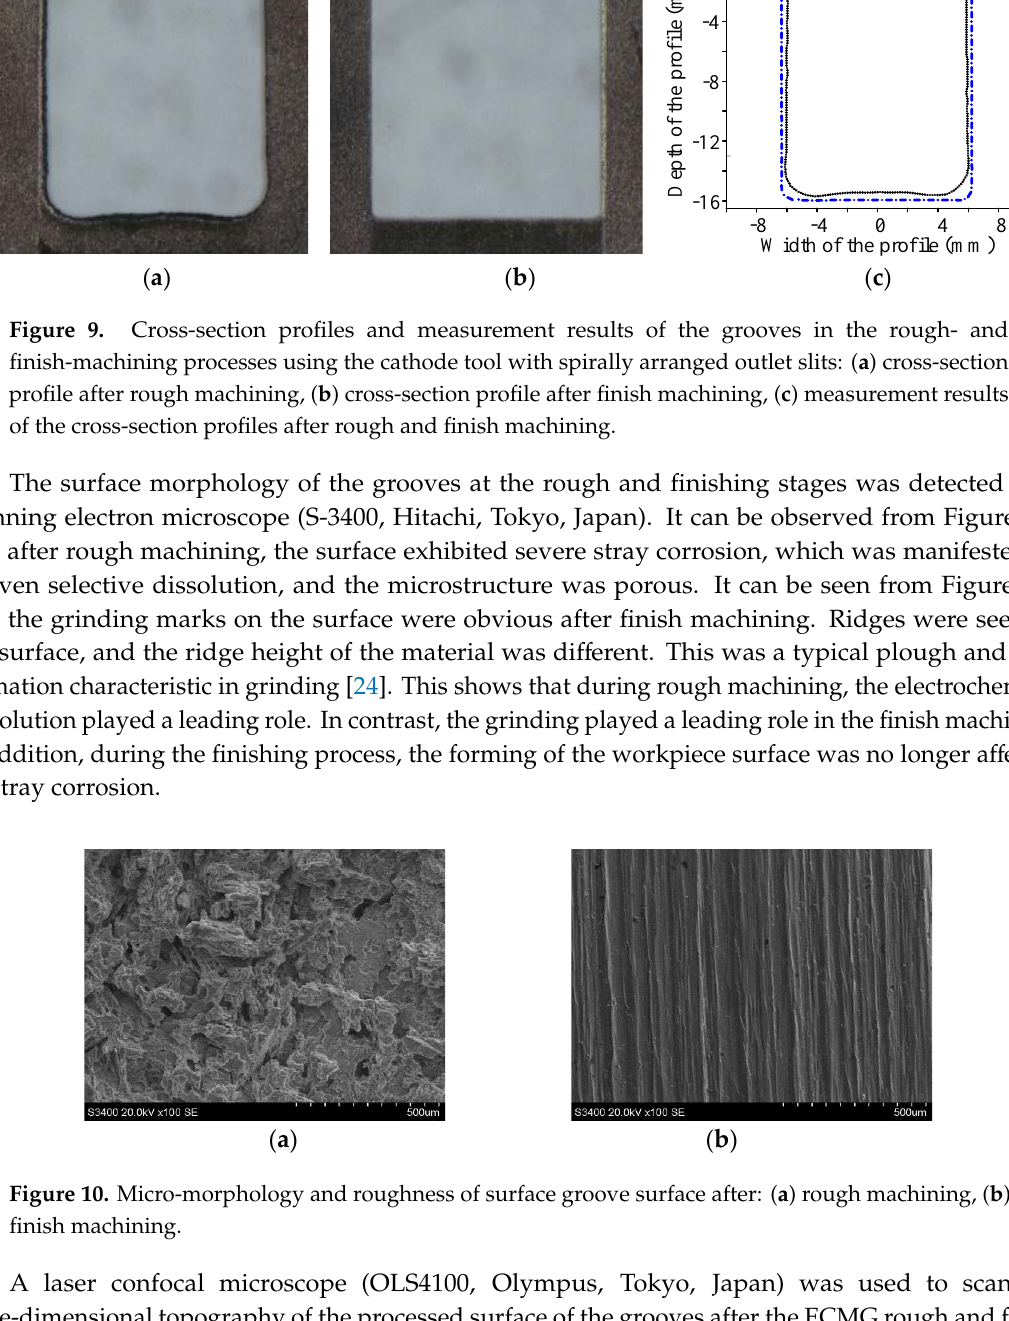
finish machining. finish